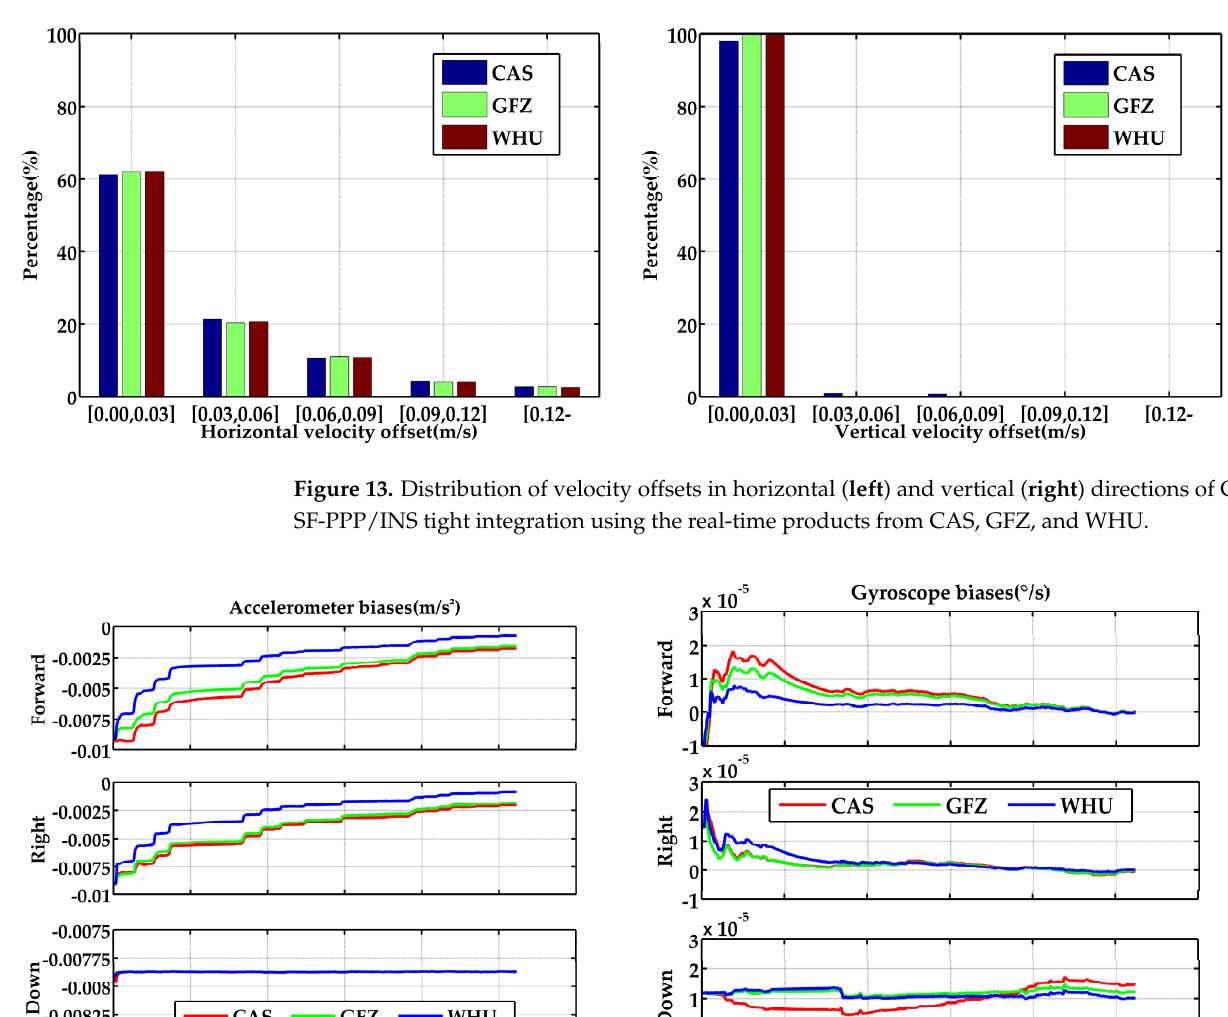
Figure 12. Velocity offsets of G + B SF-PPP/INS tight integration in the three directions using the real-time products from CAS, GFZ, and WHU, in terms of reference solutions (the start time is 195,453 s).